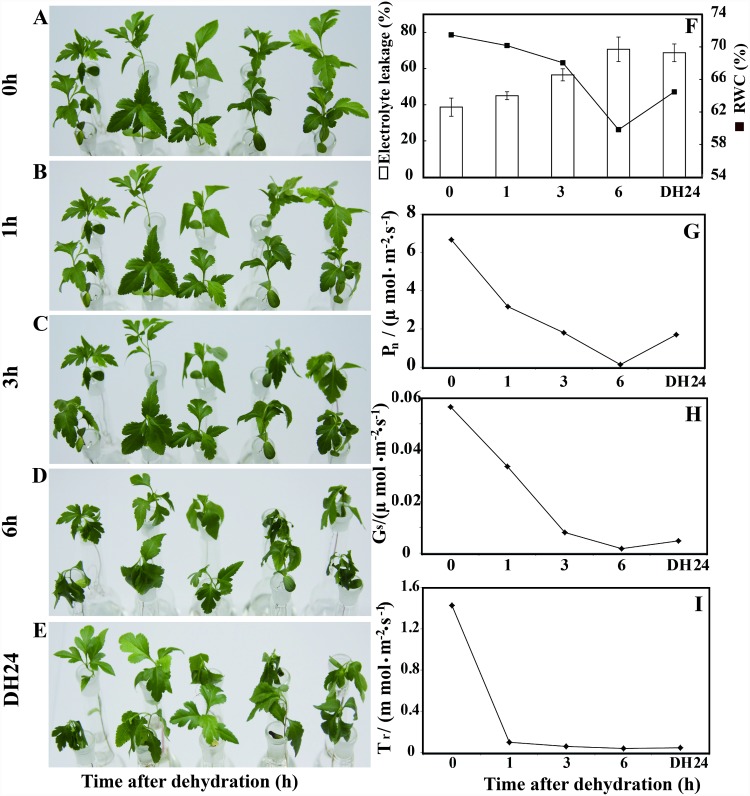
Time-course fresh water loss of Pyrus betulaefolia seedling during dehydration for 0, 1, 3 and 6 h in an ambient environment at 26°C, followed by recovery in water at 26°C for 24 h.(A-E). Electrolyte leakage and relative water content (RWC) analysis of Pyrus betulaefolia leaves. (F). Content of photosynthetic rate (Pn) (G); content of stomatal conductance (Gs) (H); content of transpiration rate (Tr) (I).